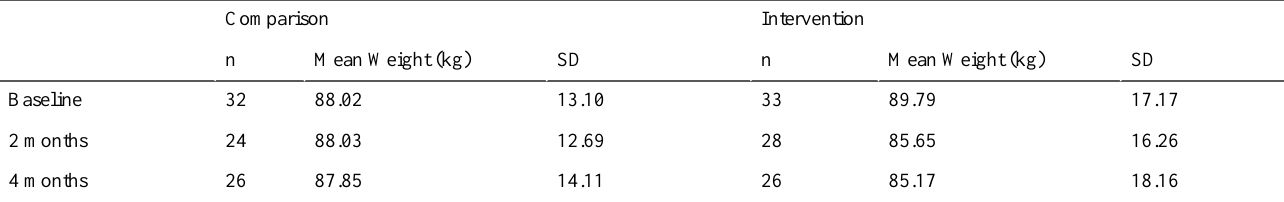
Table 3. Unadjusted mean weights by